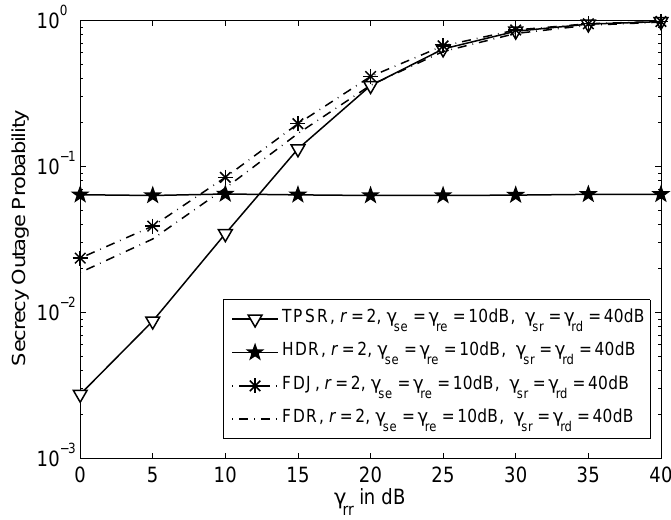
Figure 6. Outage probability versus inter-relay interference or self-interference, γ rr where target secrecy rate, r = 2bits/s/Hz, γ se = γ re = 10dB and γ sr = γ rd =